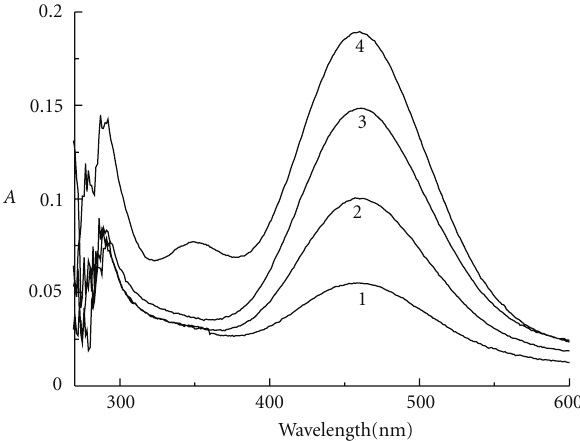
Figure 2: The absorbance versus wavelength at equilibrium: curve 1: r = 2 . 03; curve 2: r = 3 . 00; curve 3: r = 3 . 95; curve 4, r = 4 . 85. of potassium iodide reaction with iodine, the solution of iodine, and the solution of potassium iodide in the range of 200 nm–1000 nm wavelength, respectively. Figure 1